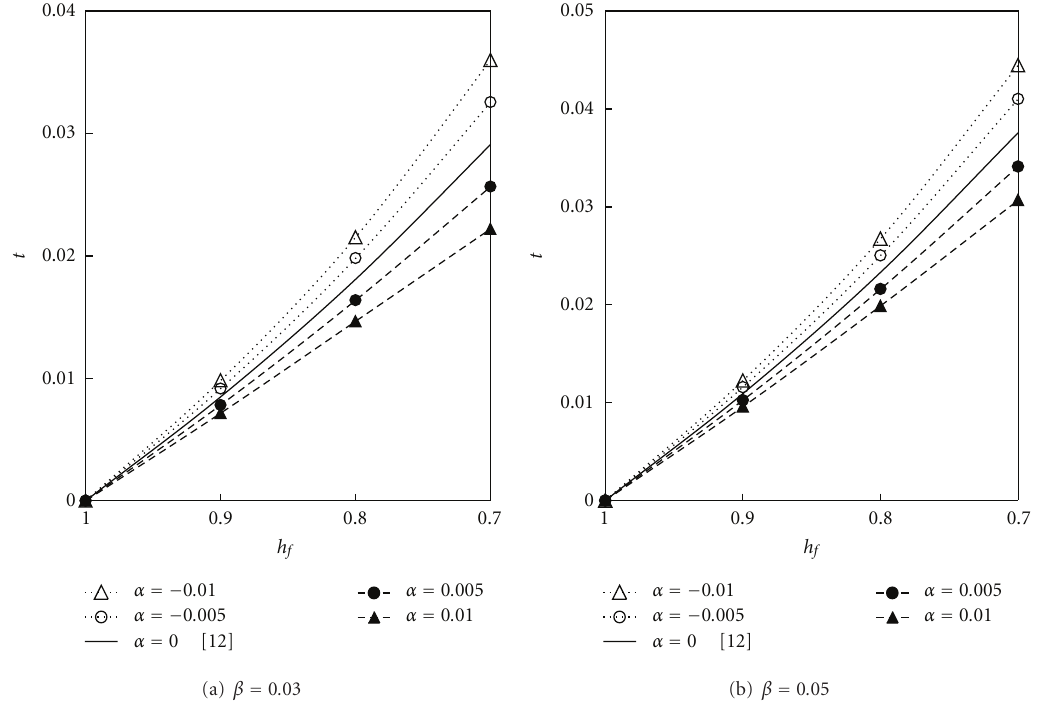
e ff ects of lubricant additives on the performance character- istics of squeezing film between a sphere and a plate are presented avoiding the inertia and cavitation e ff ects. The analytical solution for pressure distribution is obtained using a classical perturbation technique. Based on the present theoretical analysis, the following results have been